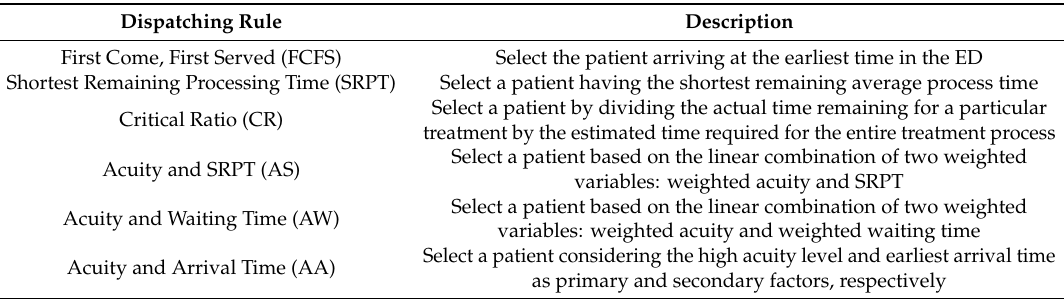
Table 5. Dispatching